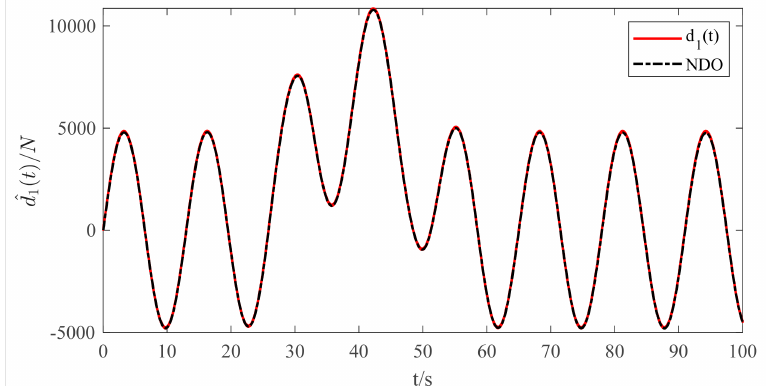
Figure 6. Underwater robot boundary disturbance